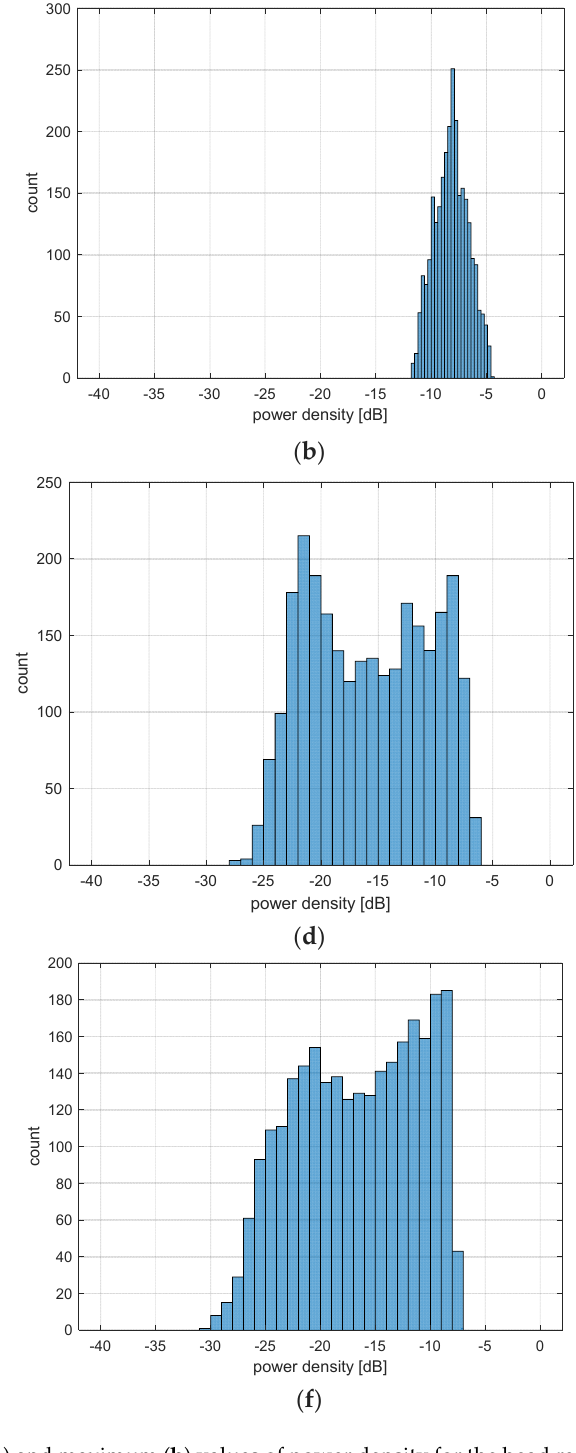
Figure 7. The histogram of average ( a ) and maximum ( b ) values of power density for the head region, of average ( c ) and maximum ( d ) values of power density for the left eye region and of average ( e ) and maximum ( f ) values of power density for the right eye region. Specifically, the regions of eyes and head were approximated by means of an ellipti- cal contour: in each elliptical region Average Values (AV) and Maximum Values (MV) of